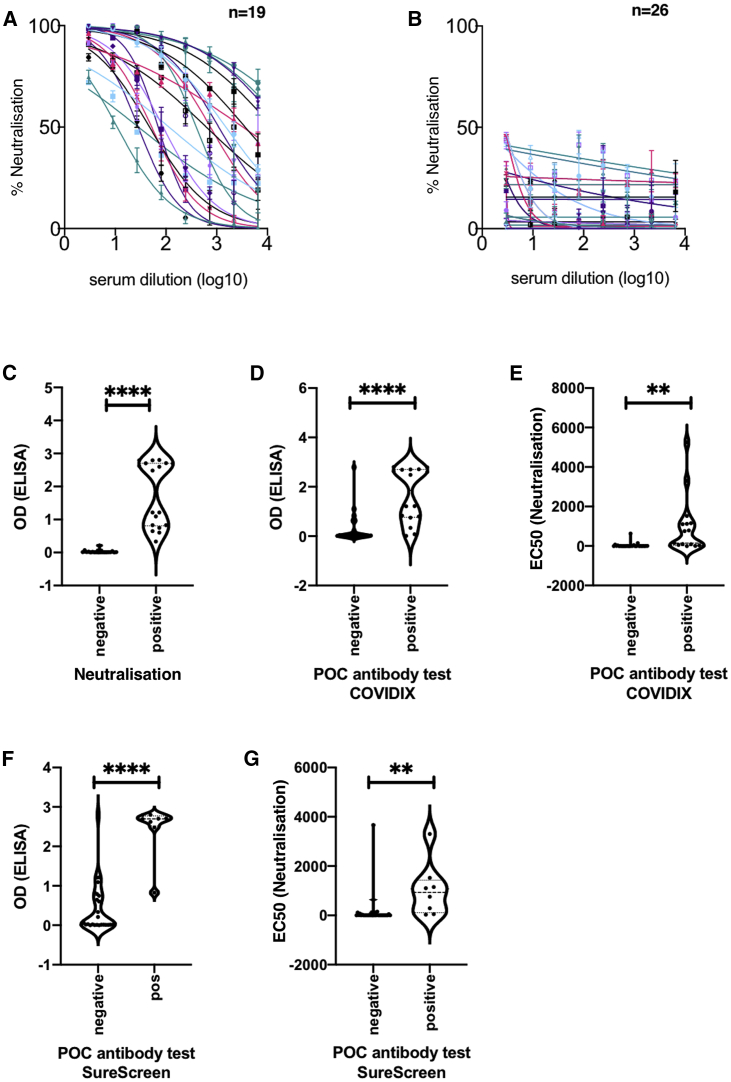
Antibody Detection for SARS-CoV-2: Cross-Validation of Lateral Flow Diagnostic Tests (POC Antibody Tests) with ELISA and SARS-CoV-2 Pseudotype Virus Neutralization Assays(A and B) Serum from COVID-19 suspected participants inhibited (n = 19) (A) or did not inhibit (n = 26) (B) SARS-CoV-2 pseudotype virus infection in a neutralization assay. Serum from a healthy donor was used and a negative control. The error bars represent SEMs.(C) Comparison between ELISA and positive/negative results from neutralization assay; n = 37, p < 0.0001.(D) Comparison between ELISA Spike protein reactivity and positive/negative POC antibody test results (COVIDIX SARS-CoV-2 IgM/IgG test); n = 38, p < 0.0001.(E) Comparison between half-maximal effective concentration (EC50) dilution titer from neutralizing assay and positive/negative POC antibody test results (COVIDIX SARS-CoV-2 IgM/IgG test); n = 44, p = 0.0025.(F) Comparison between ELISA IgG and positive/negative POC IgG band results for SureScreen SARS-CoV-2 IgM/IgG test; n = 38, p < 0.0001.(G) Comparison between EC50 dilution titer from neutralization assay and positive/negative SureScreen SARS-CoV-2 IgM/IgG antibody band test results; n = 43, p = 0.005. The assays were performed in duplicate.